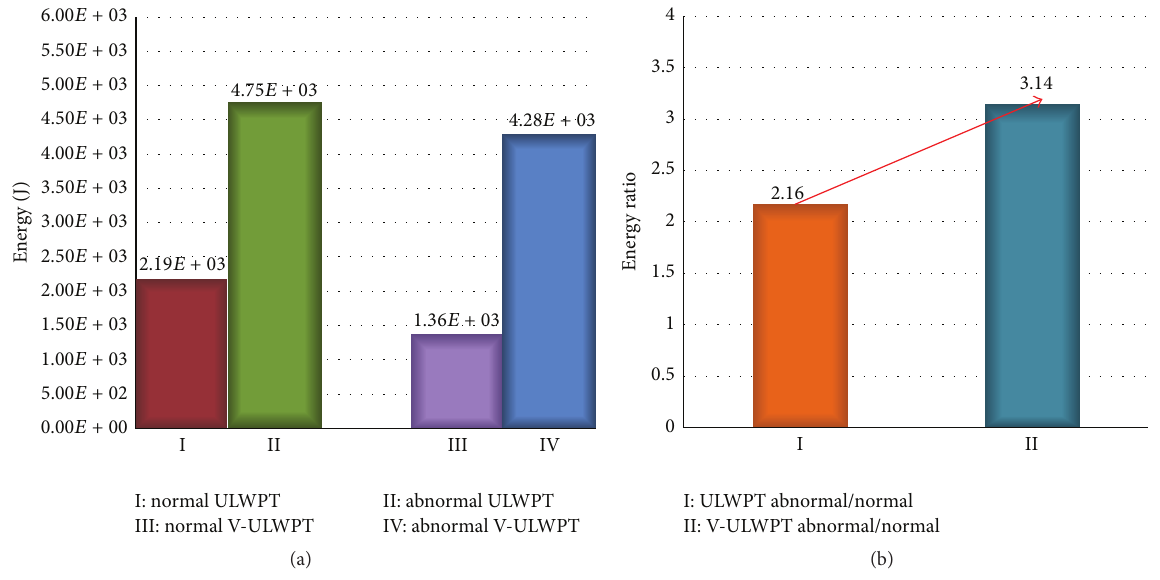
Figure 9: Energy comparison among different conditions: (a) energy comparison chart, (b) energy ratio